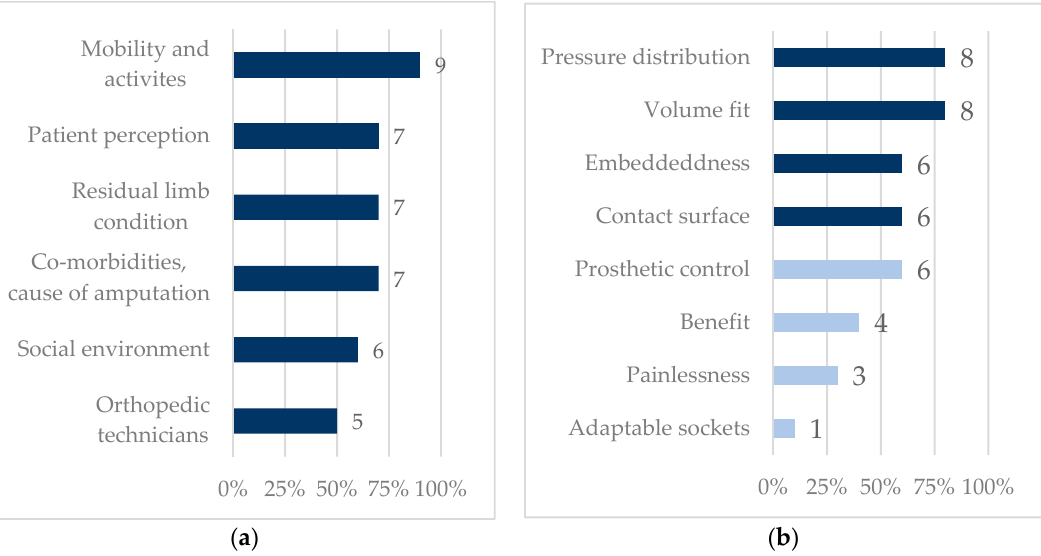
Figure 2. Assessment of the influencing aspects for socket manufacturing: ( a ) Factors influencing socket manufacturing; ( b ) Socket requirements due to the orthopedic technician (dark bars: technical requirements; light bars: functional